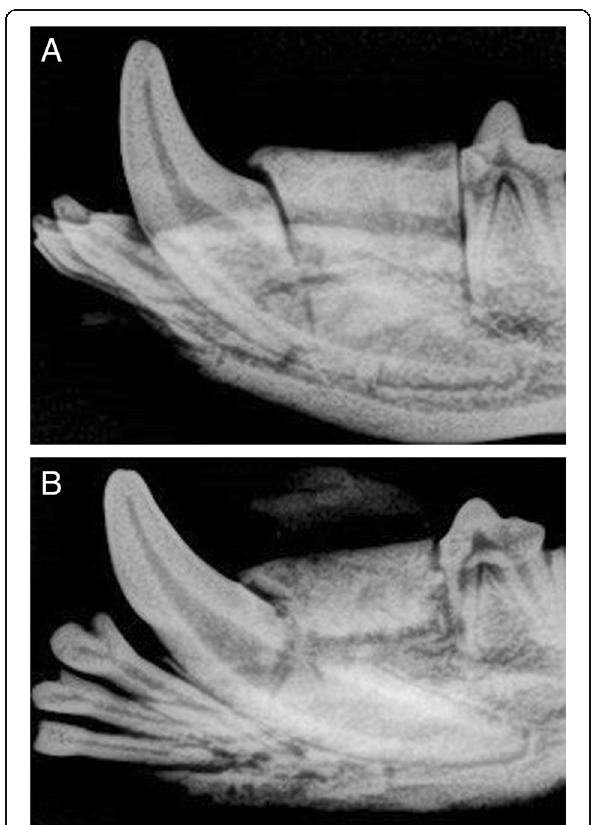
Fig. 4 a Peri-apical X-ray of zirconia scaffold immediately placed in bone defect. Margins between scaffold and bone are clearly demarcated. b Peri-apical X-ray of zirconia scaffold after completion of healing time. Margins between bone defect and scaffold are less demarcated due to new bone